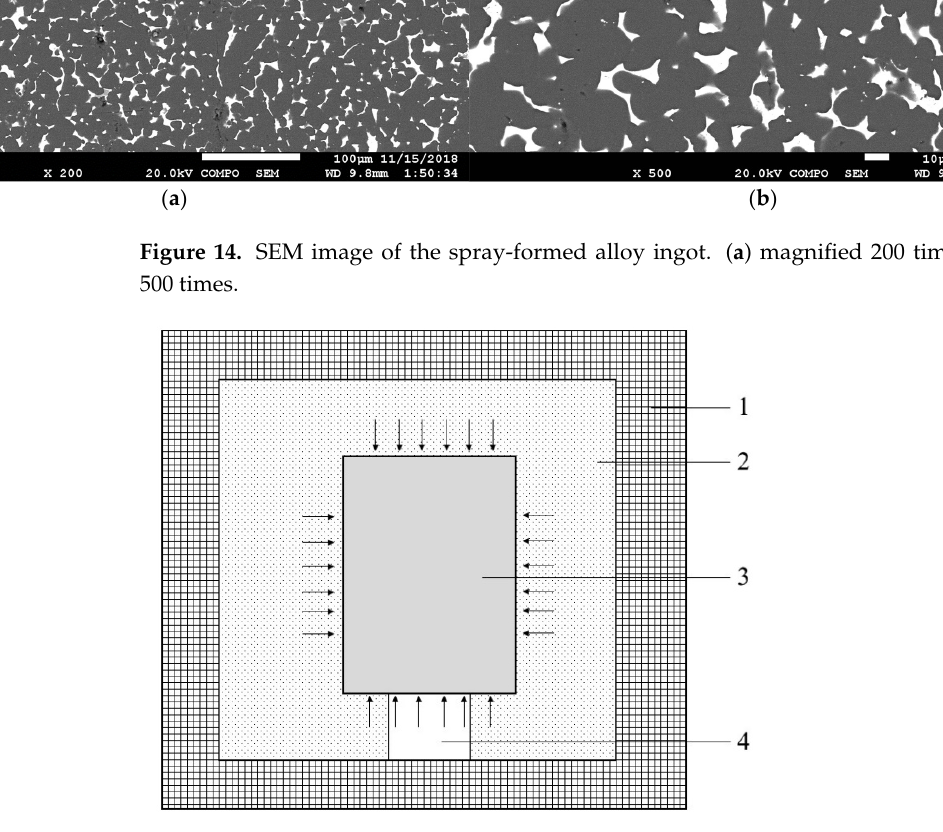
Figure 15. Schematic diagram showing the densification process of hot isostatic pressing. 1: hot isostatic pressing furnace, 2: gas, 3: billet, 4: holder.